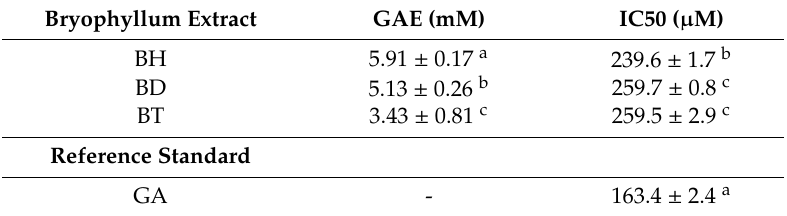
Table 1. Total phenolic content (TPC), expressed as total gallic acid equivalents (GAE, mM) of Bryophyllum species investigated and their antiradical activity expressed as IC50 value (in µ M). GA was included as reference standard. Values were expressed as the mean ± standard deviation of three independent replicates. Di ff erent letters indicate significant di ff erences ( α =